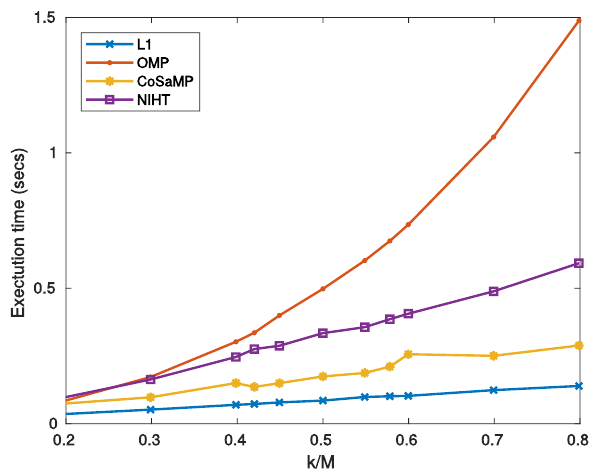
Figure 9. Case Study A—Execution time on MATLAB as a function of sparsity S M = k / M .